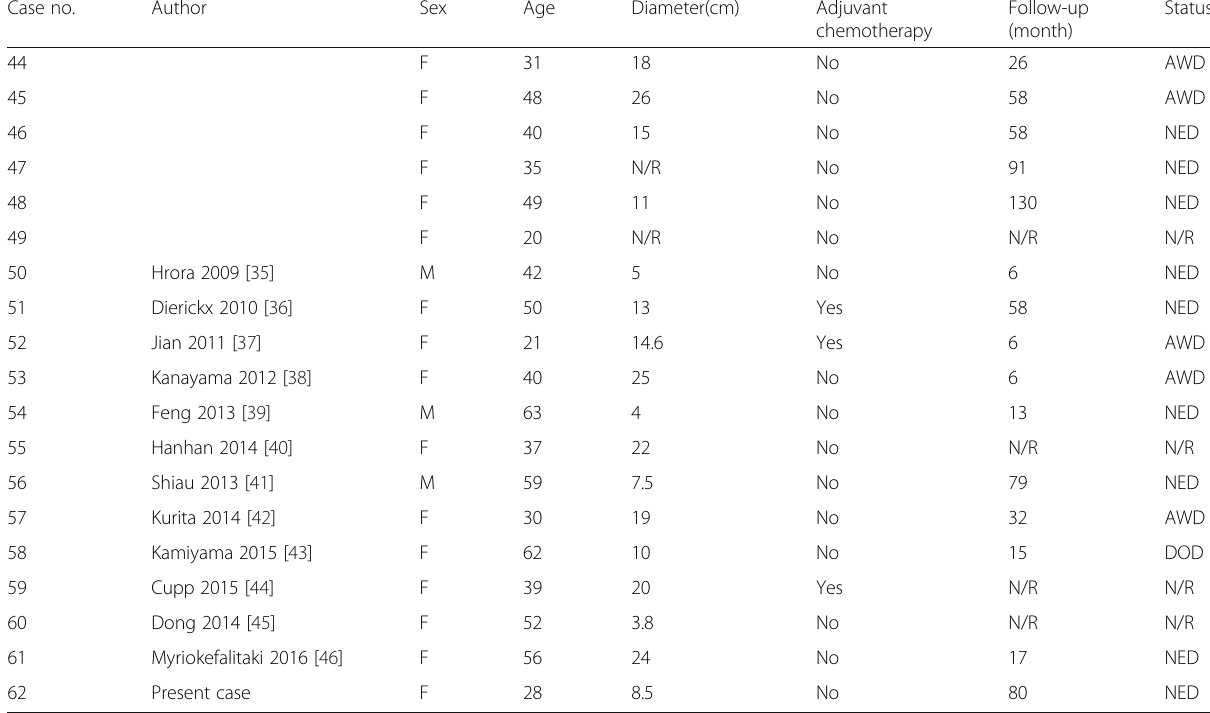
Table 1 Published English studies searched in PubMed (Continued) Case